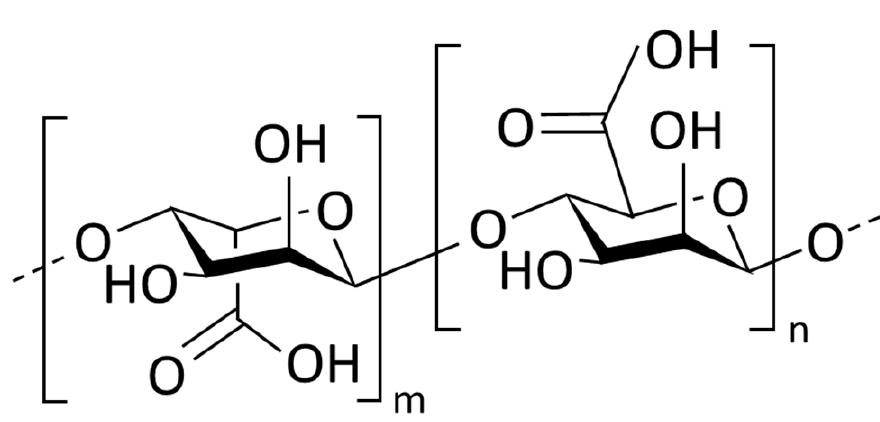
Figure 2. Molecular structure of sodium alginate Reprinted with permission from ref. [30]. Copyright 2017 Springer Nature. Table 2. Material properties of sodium alginate